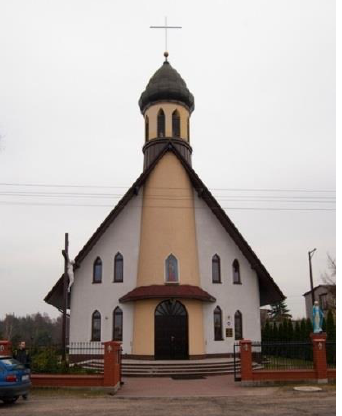
Figure 8. Church of St. Thomas Apostol in Osiny (built in 1990–1991).